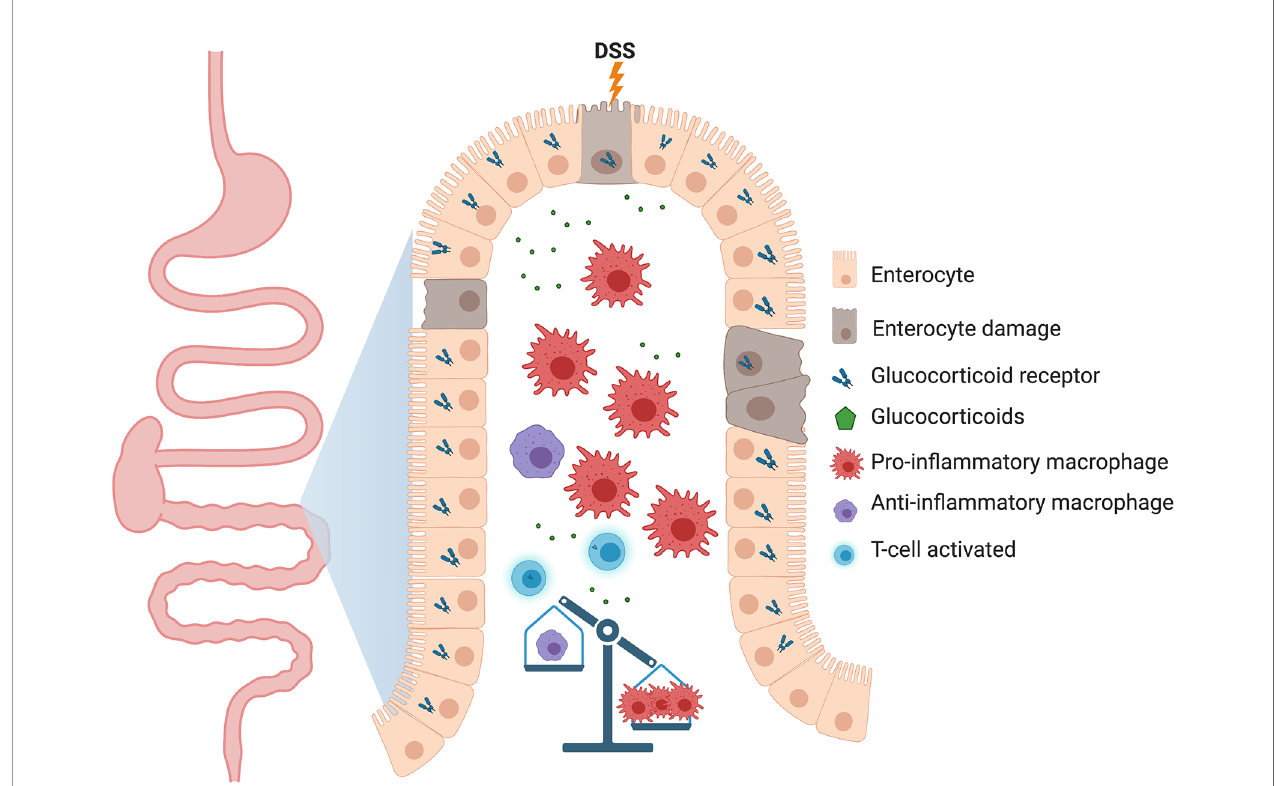
FIGURE 3 | Proposed model of how the lack of glucocorticoid receptor (GR) in macrophages could be detrimental to gastrointestinal tissue homeostasis. In the dextran sodium sulfate (DSS)-induced colitis model, deletion of GR in myeloid cells delays the resolution of in fl ammation through an increase in the number of pro- in fl ammatory macrophages which perpetuates tissue damage. Other immune cells, such as B cells, dendritic cells and ILCs relevant to the intestinal physiology have been deliberately neglected to highlight the function of